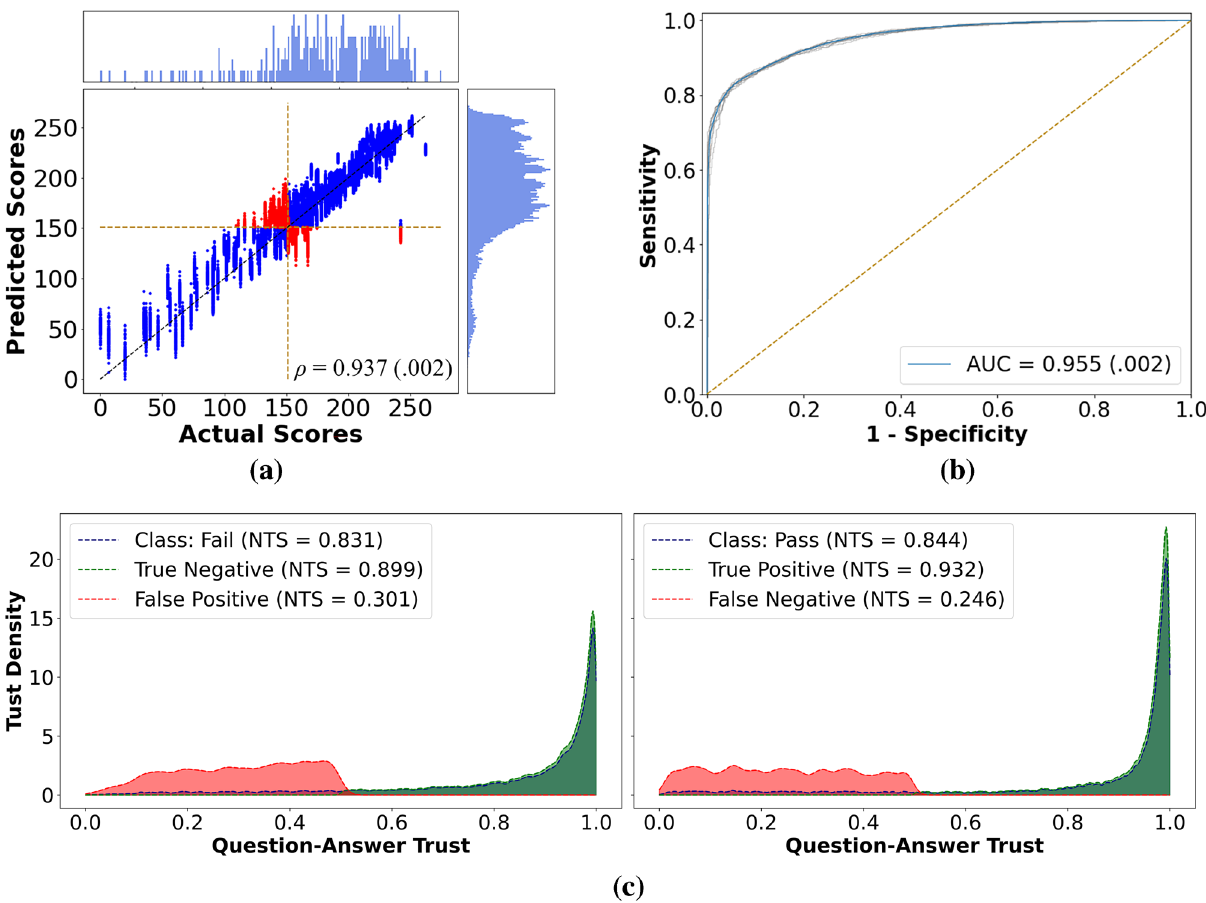
Figure 3. Results for the additional PC datasets. (a) Actual vs. predicted FLS scores for all ten runs. Here, we did not observe inflated score prediction, as shown in Fig. 2. This may be due to a more balanced representation of the samples. (b) The ROC curves. (c) Question–answer trust plots for each class. We observed the same confident true predictions and cautious wrong predictions trend in this plot compared to Fig. 2c.